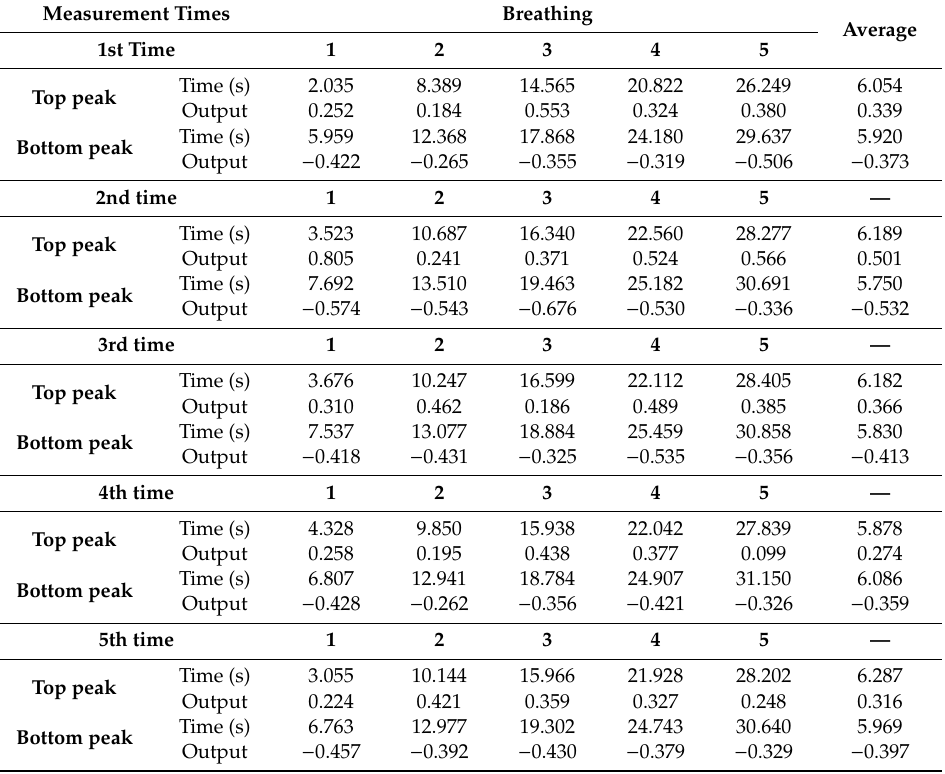
Table 2. Detection time and output value of top and bottom peaks measured by FBG sensor.